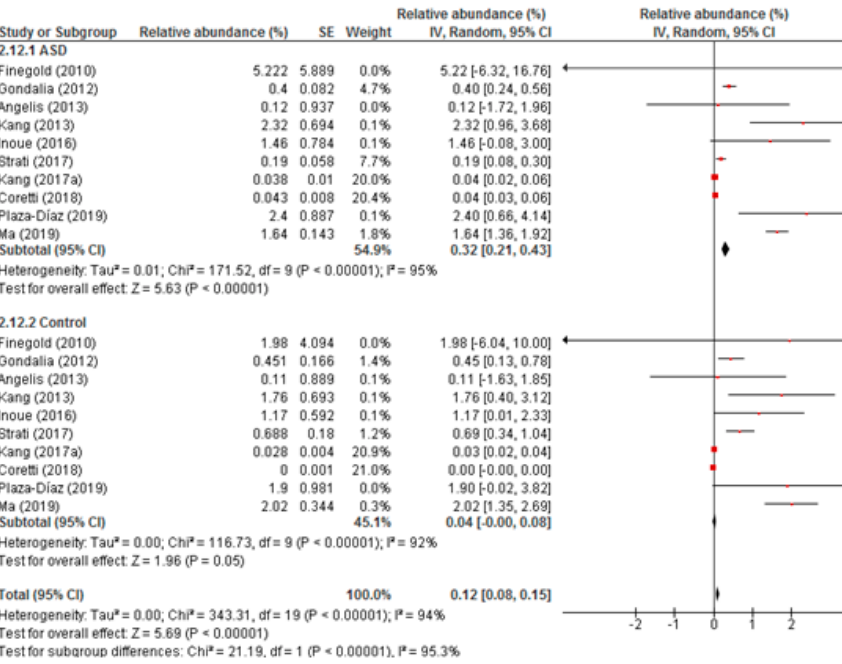
Figure 3. Forest plot of relative abundance of Parabacteroides in children with ASD and controls.